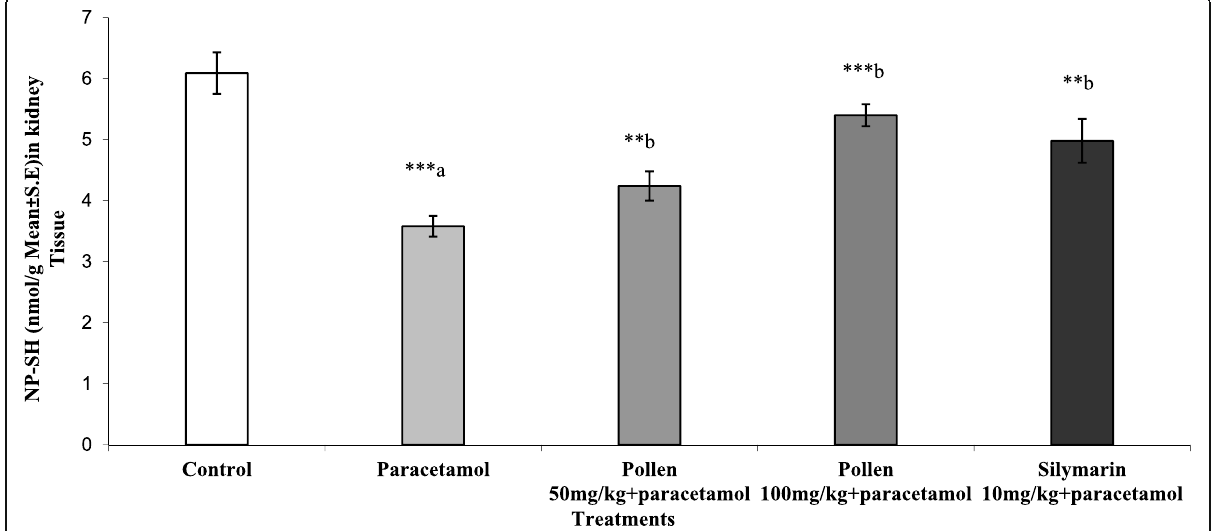
Fig. 5 Kidney tissue Non Protein sulfhydryls (NP-SH) levels. NP-SH levels in rats intoxicated with APAP alone and treatment with DPP and Silymarin. All values represent mean ± SEM. ** p < 0.01, *** p < 0.001; ANOVA, followed by Dunnett ’ s multiple comparison test. a As compared with control group. b As compared with APAP group